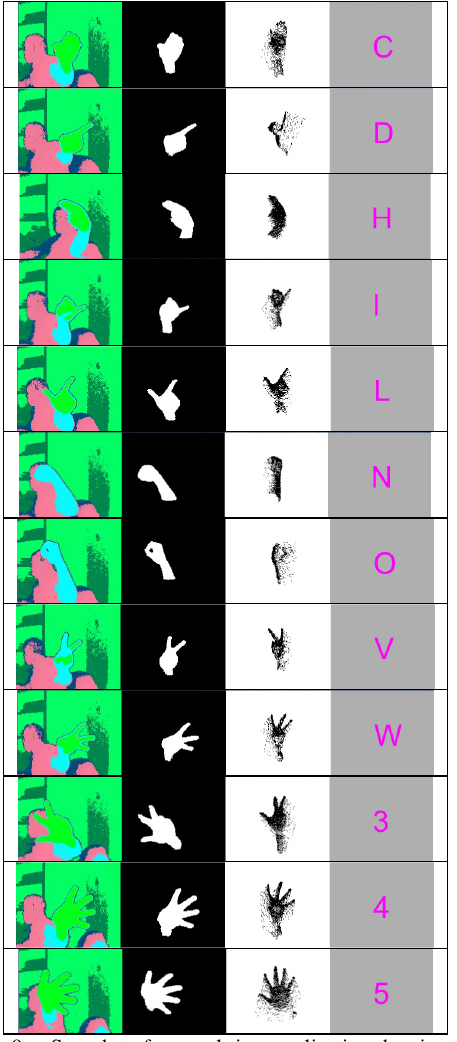
Fig. 9. Snapshots from real-time application showing the original range image, the segmented hand blob and the recognized hand postures